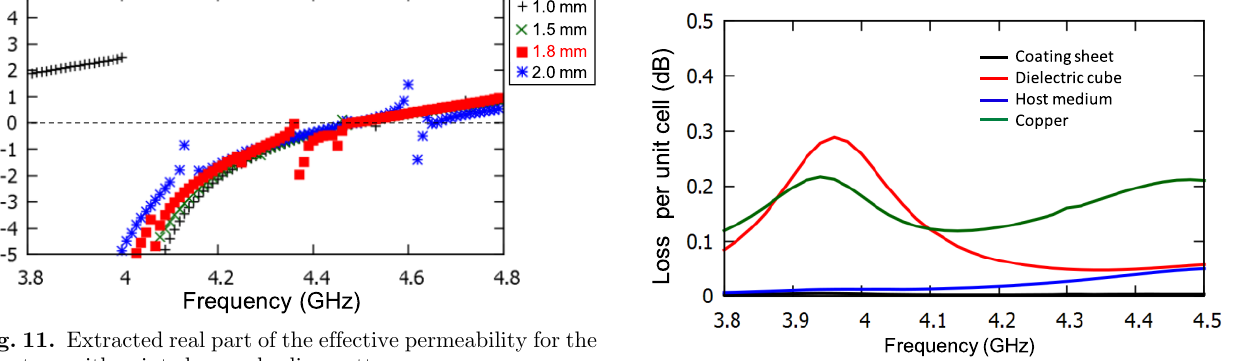
Fig. 13. Classi fi cation of losses per unit cell for the designed metamaterial with d =